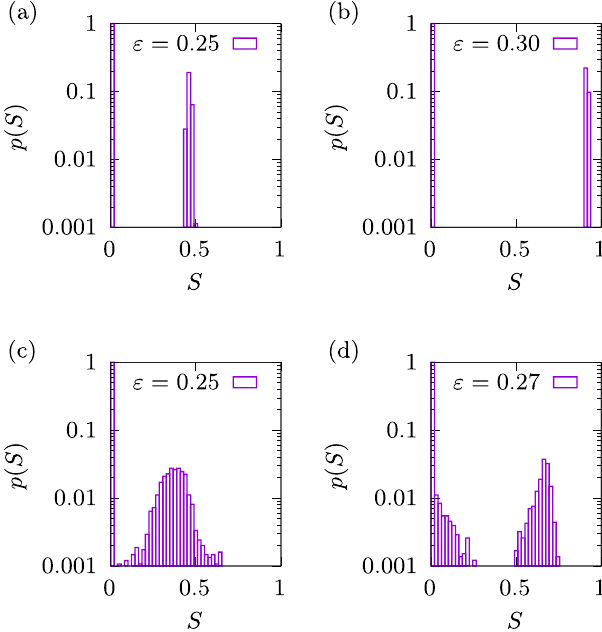
Fig. 6 Comparison of cluster size distribution for hypergraphs of different topology. Cluster size distribution of systems of size N = 65,536, below and above the corresponding critical con fi dence value, ε c . a , b ER 3-uniform